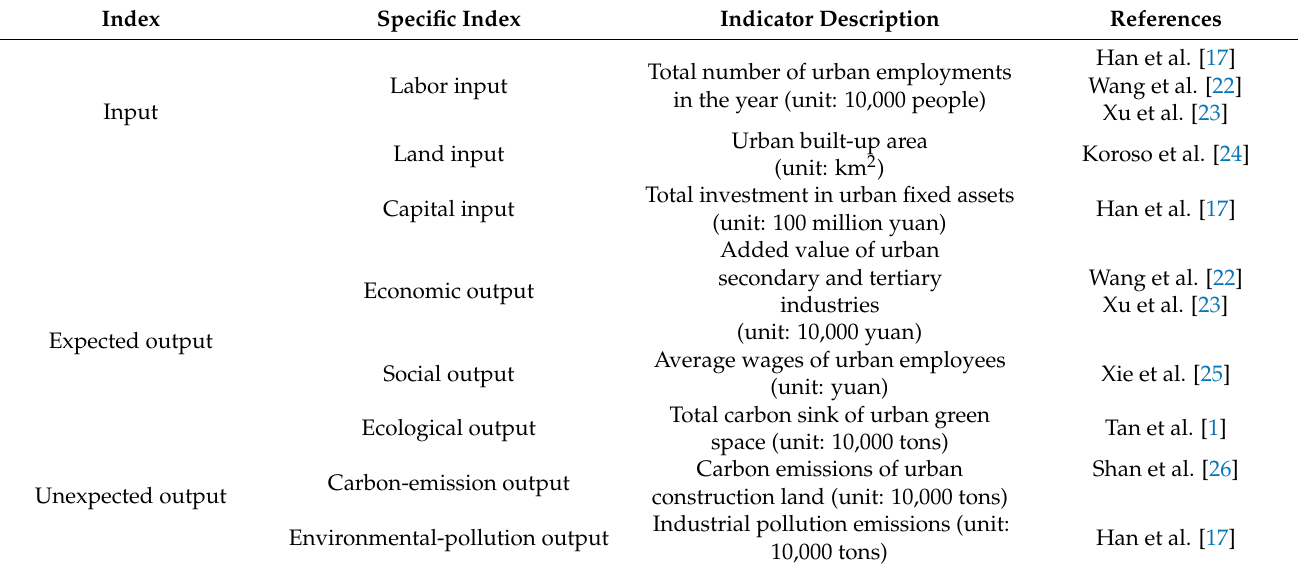
Table 1. Input and output indicators of